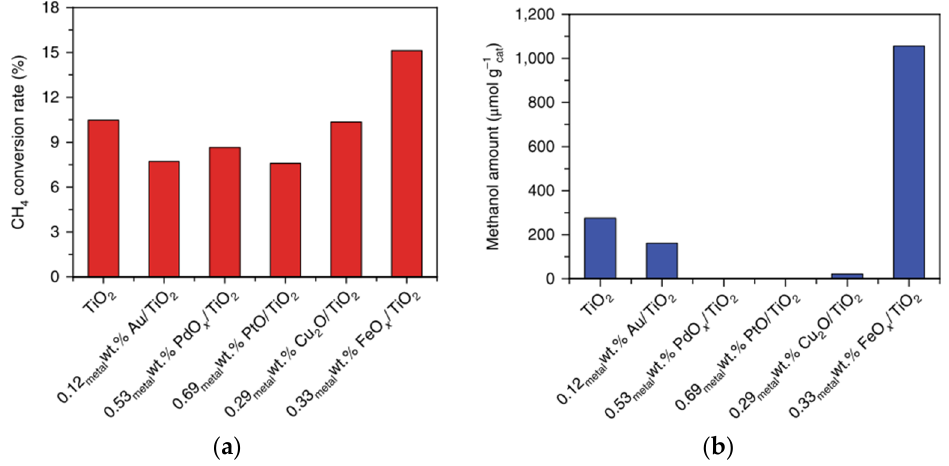
Figure 22. Photocatalytic activity of TiO 2 with several co-catalysts ( a ) methane conversion and ( b ) ethanol selectivity [81]. Reproduced with permission from Xie et al. Copyright © 2022 Springer Nature.